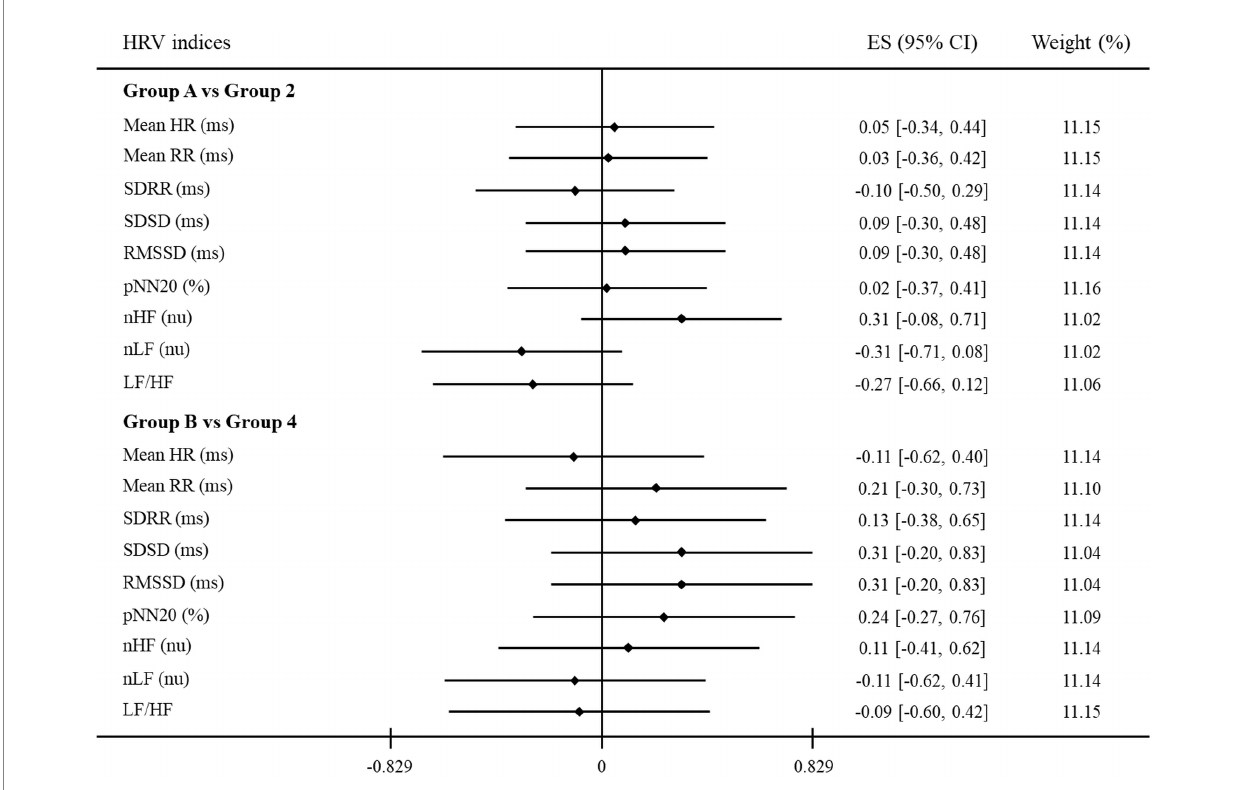
FIGURE 3 A forest plot showing the effect sizes (ES) and confidence intervals (CI) of HRV indices compared between groups. The vertical solid black line represents a mean difference of zero or no effect. Each black diamond shows the standardized mean difference. The upper and lower range of the line connected to the diamond shows the 95% CI for the ES. Group A: no depression group; Group 2: only self-rated depression; Group B: no anxiety group; Group 4: only self-rated anxiety. HRV, heart rate variability; Mean HR, mean heart rate; Mean RR, mean of all RR intervals; SDRR, standard deviation of all RR intervals; SDSD, standard deviation of differences between adjacent RR intervals; RMSSD, root mean square of successive RR interval differences; pNN20, percentage of differences between adjacent RR intervals >20 ms; nHF, normalized high-frequency power; nLF, normalized low- frequency power; LF/HF, low- to high-frequency